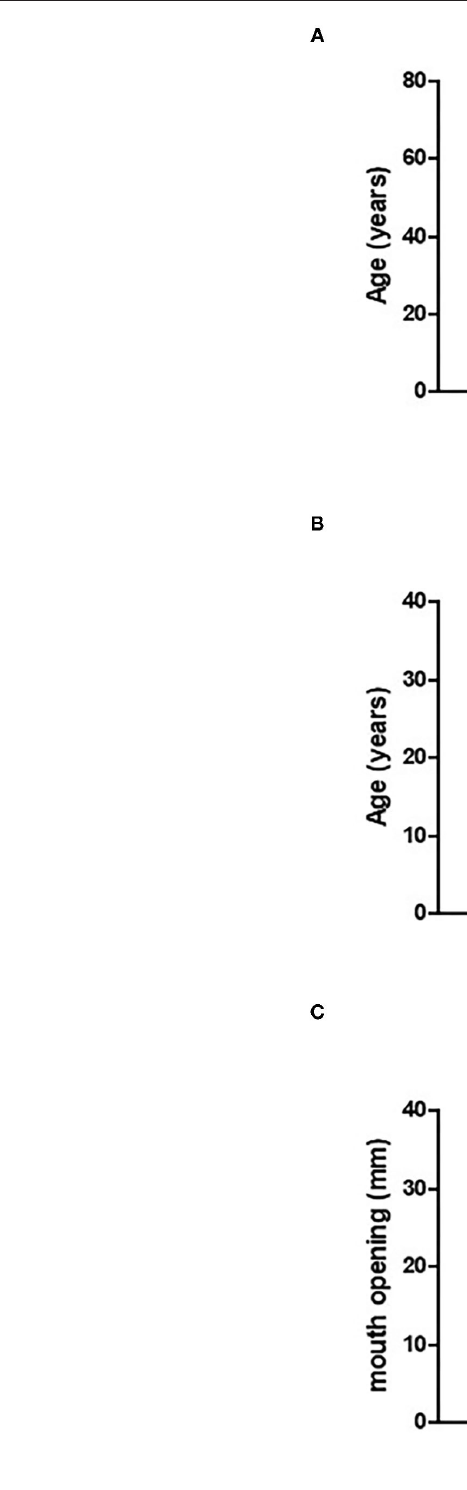
Frontiers in Medicine |